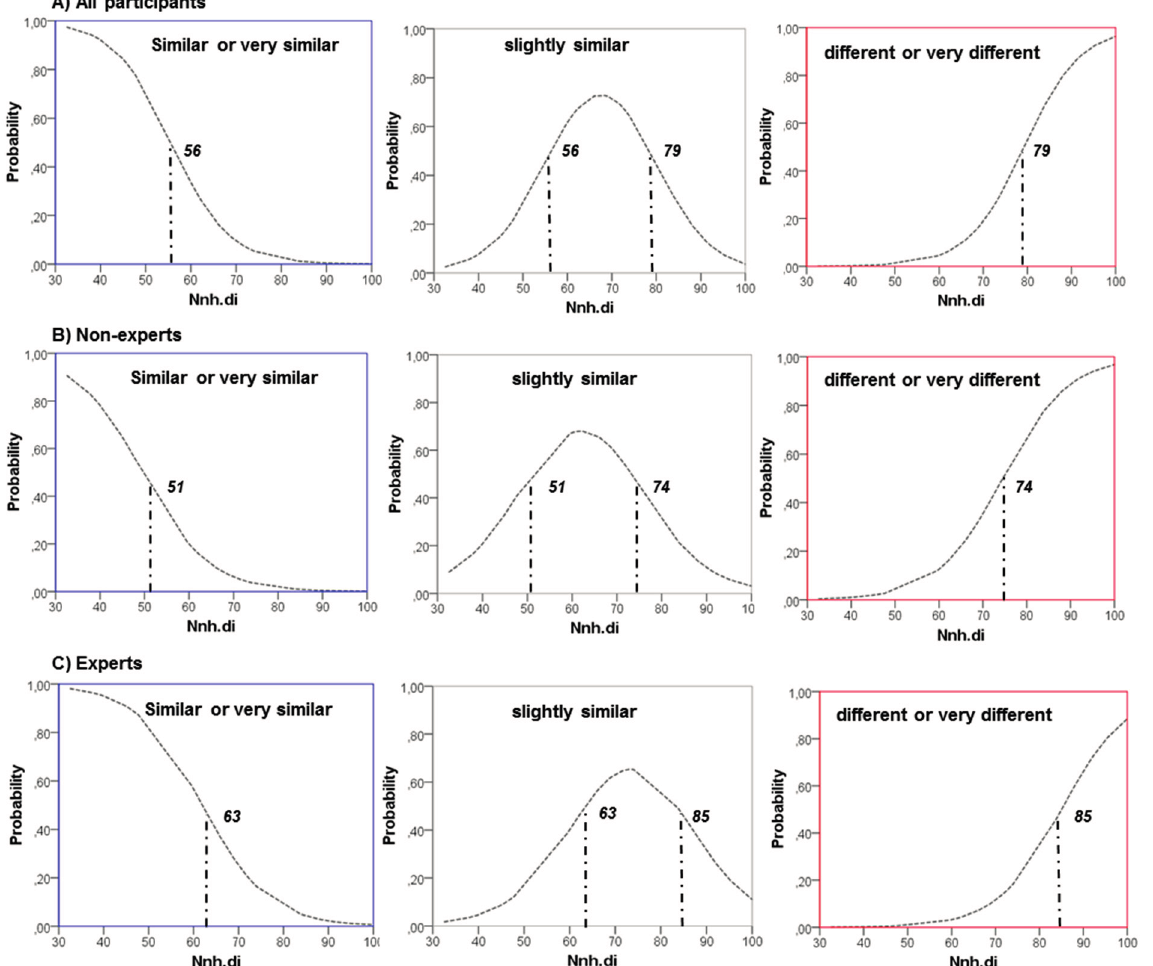
Figure 5. Nnh.di results and estimated probability of perceived similarity in three ordered categories (very similar/similar, slightly similar and different/very different) for each group (( A ) all participants; ( B ) non-experts; ( C )